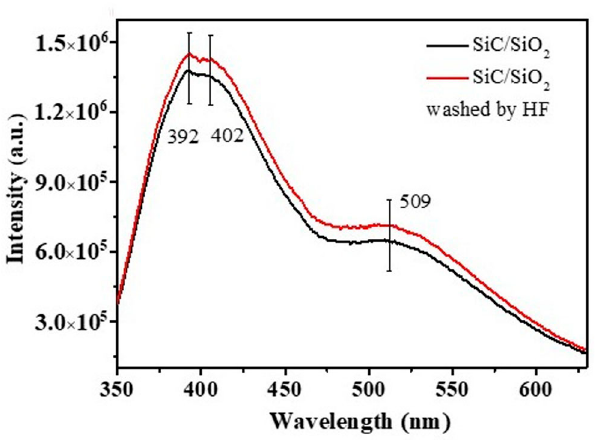
Figure 9. Emission spectra of SiC/SiO 2 heterojunctions after HF treatment.